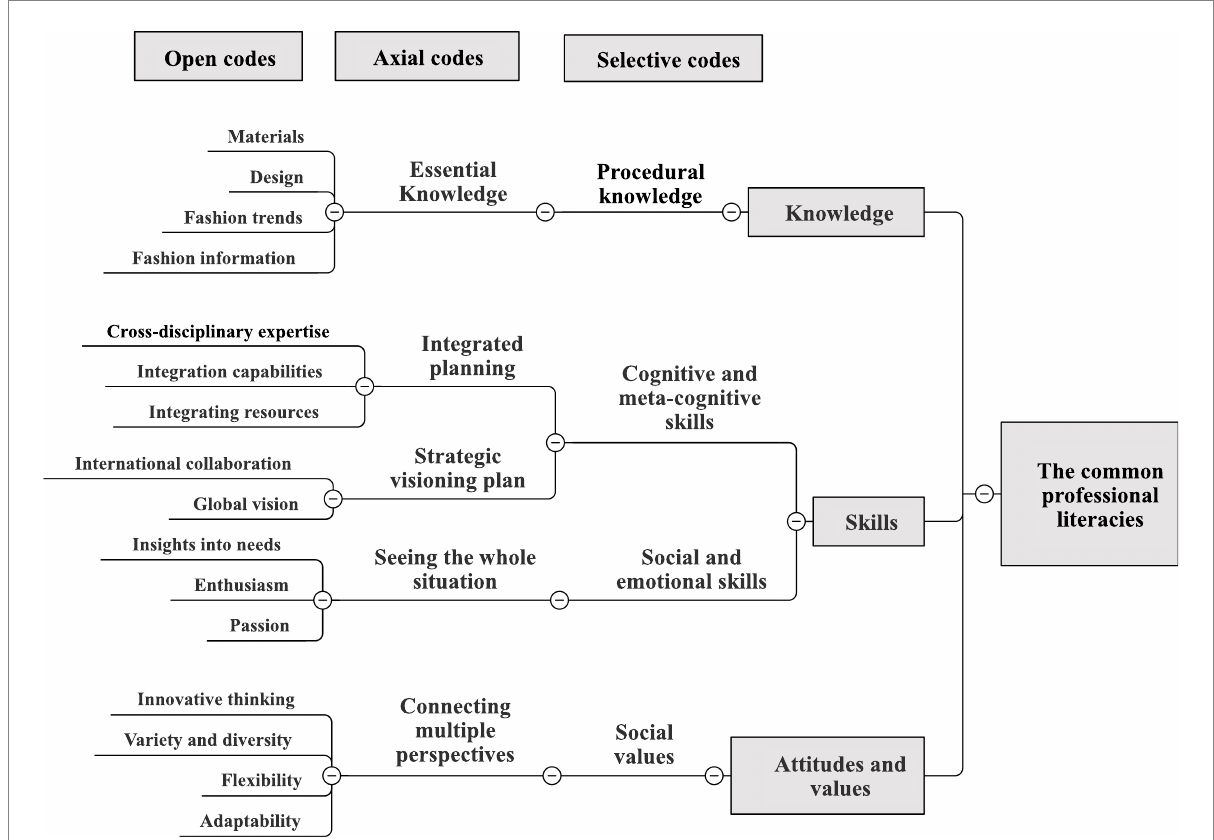
FIGURE 1 Taiwan’s bag manufacturing industry talents’ common professional literacies